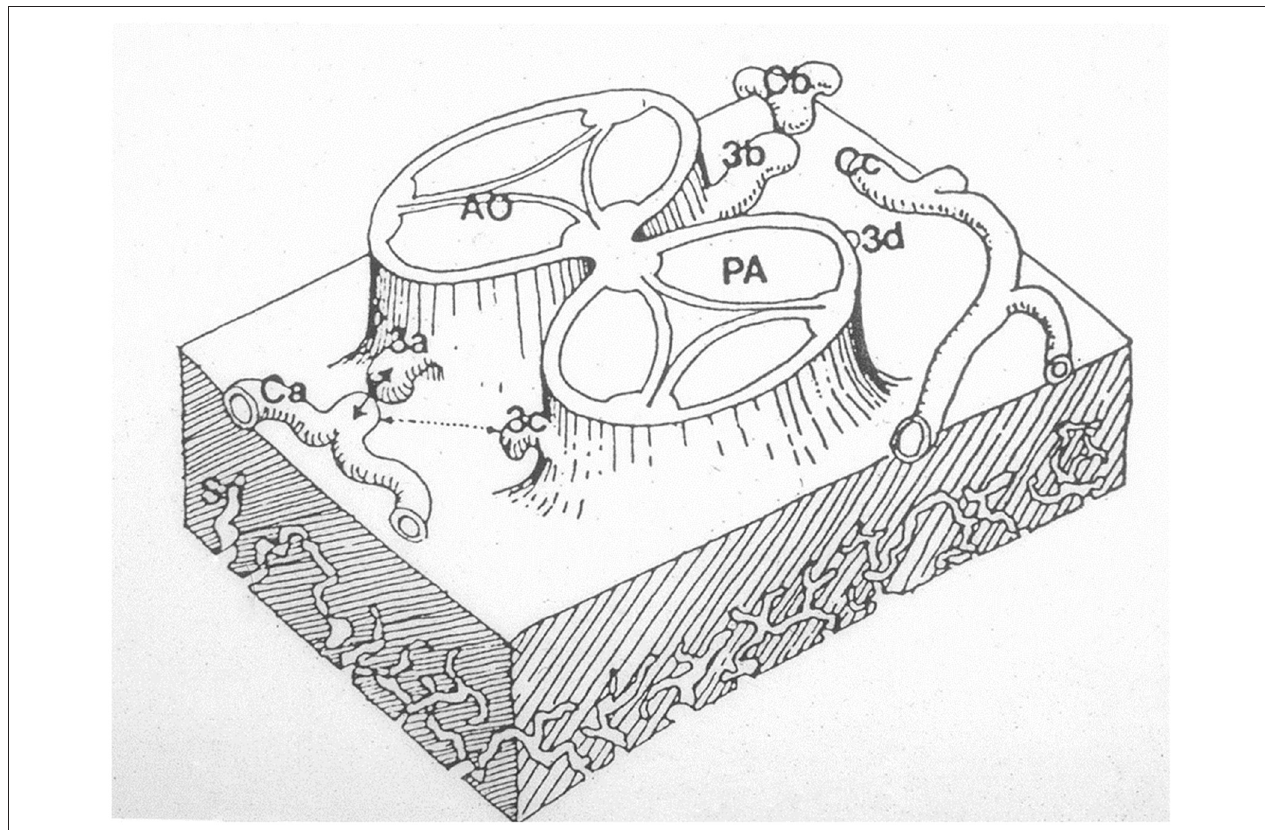
FIGURE 14 | The hypothesis according to which sprouts or buds arise from the facing aortic sinuses and make contact with the subepicardial coronary vasculature. From Angelini ( 18).